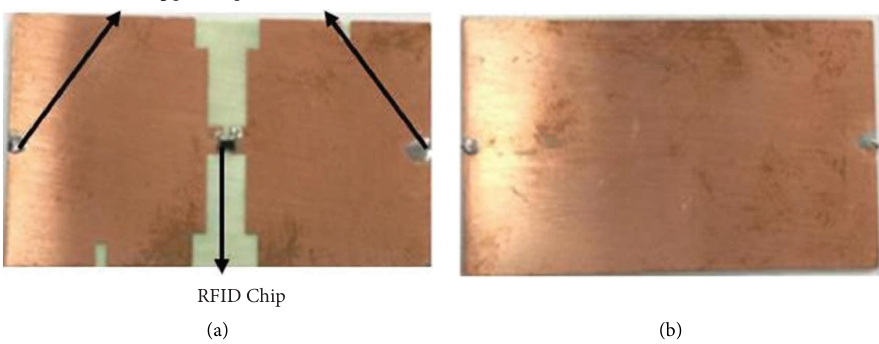
Figure 13: (a) Top and (b) bottom side of fabricated prototype of designed tag.